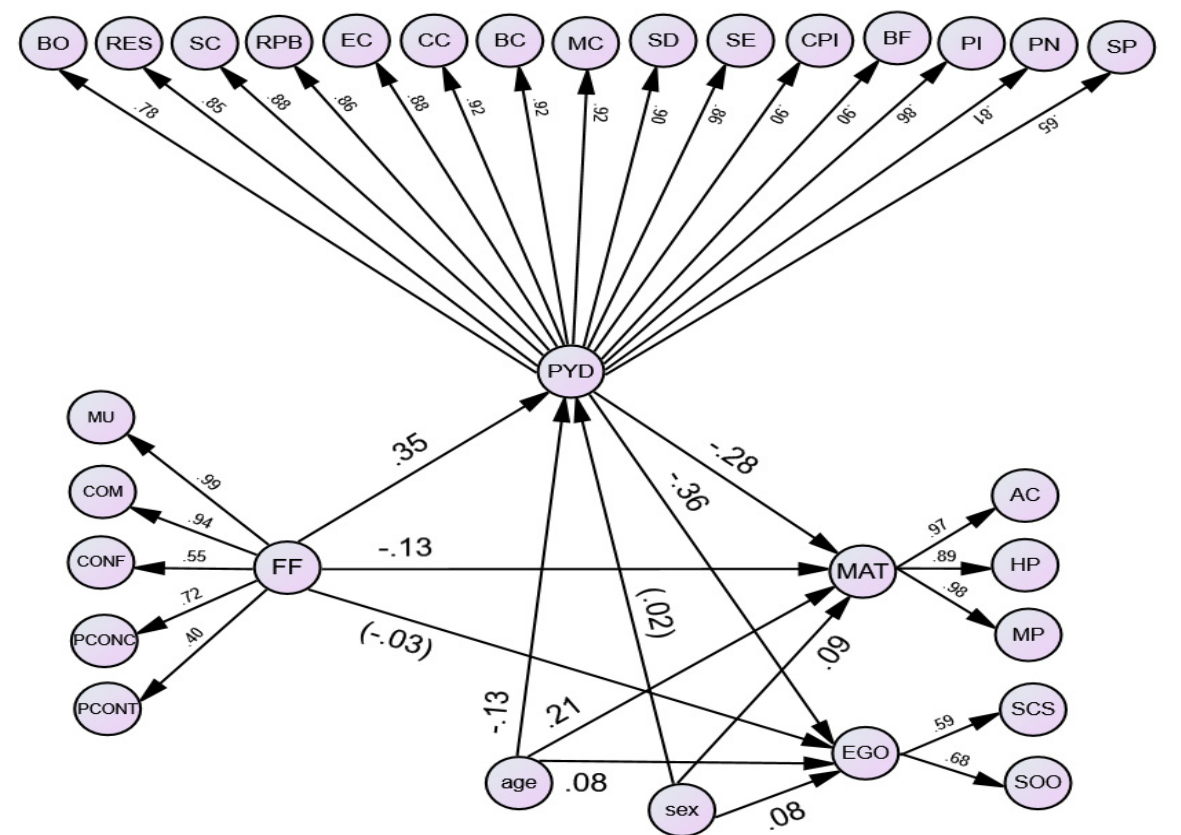
Figure 2. Overall SEM model of Wave 2 positive youth development on the links from Wave 1 family functioning to Wave 2 materialism and Wave 2 egocentrism controlling for age and sex. Note: All estimates are standardized ones. All paths were significant at 0.05 levels except for the path with the estimate in parenthesis. Indicators of all latent variables and correlations among the factors of family functioning are omitted for clarity. MU = mutuality, COM = communication, CONF = conflict and harmony, PCONC = parental concern, PCONT = parental control, FF = family functioning, BO = bonding, RES = resilience, SC = social competence, RPB = recognition for positive behavior, EC = emotional competence, CC = cognitive competence, BC = behavioral competence, MC = moral competence, SD = self-determination, SE = self-efficacy, CPI = clear and positive identity, BF = beliefs in the future, PI = prosocial involvement, PN = prosocial norms, SP = spirituality, PYD = positive youth development, AC = acquisition centrality, HP = hedonistic pursuit, MP = materialistic possession, MAT = materialism, SCS = self-conceit, SOO = self over others, EGO = egocentrism, Age = age, Sex = sex.